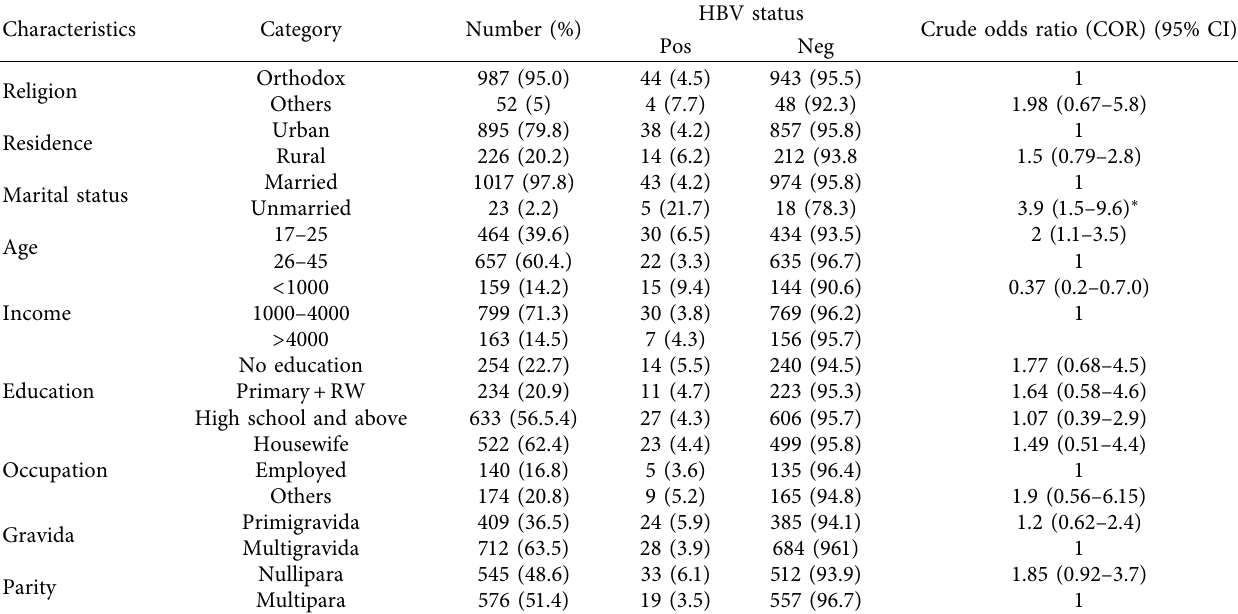
Table 3: Binary logistic regression of sociodemographic characteristics in relation to HBV infection among pregnant women in the Amhara national regional state in three tertiary hospitals from May 1, 2018, to September 30, 2019. Characteristics